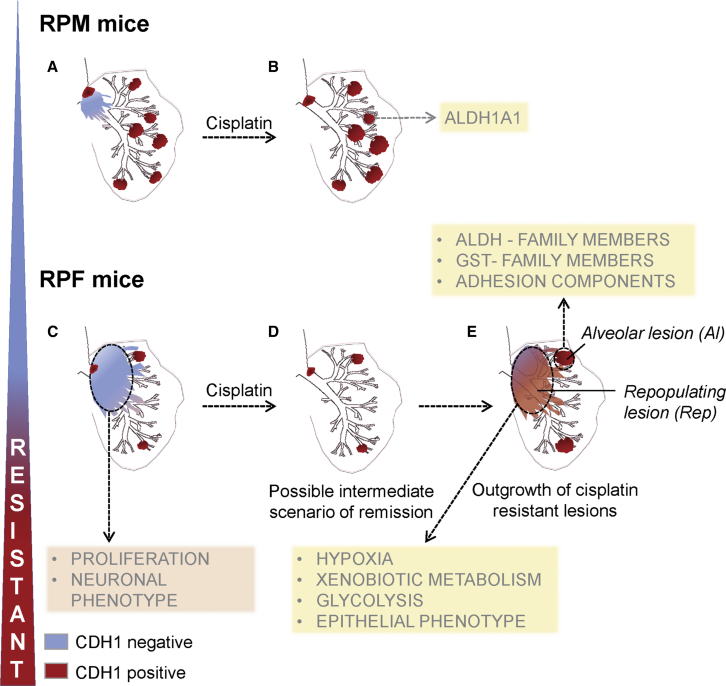
Schematic Representation of SCLC Heterogeneity in Mouse Models as Underlying Mechanism of Differential Sensitivity to CisplatinOur results suggest that the outcome of cisplatin treatment might depend on the ratio between CDH1-positive resistant primary (brown) and CDH1-negative intrapulmonary metastasis (blue) compartments within SCLC lesions.(A and B) In RPM mice, in which CDH1-positive compartment is on average predominant (A), the regression of CDH1-negative population following cisplatin treatment (B) is not sufficient to guarantee a longer survival.(C and D) In RPF mice, the sensitive CDH1-negative central compartment (C) responds to cisplatin, and consequently its regression (D) is associated with a significant survival advantage.(E) This positive response to cisplatin is followed by subsequent growth of resistant populations, similar to what is seen in patients. Resistant tumor may represent peripheral lesions, frequently present in RPM mice, and/or central lesions that repopulate the empty peri-vascular/peri-bronchial space left behind following elimination of the sensitive population. The targeting of metabolic pathways (yellow rectangles) active in the resistant populations, in combination with cisplatin treatment, may offer an opportunity to eradicate recalcitrant SCLC.